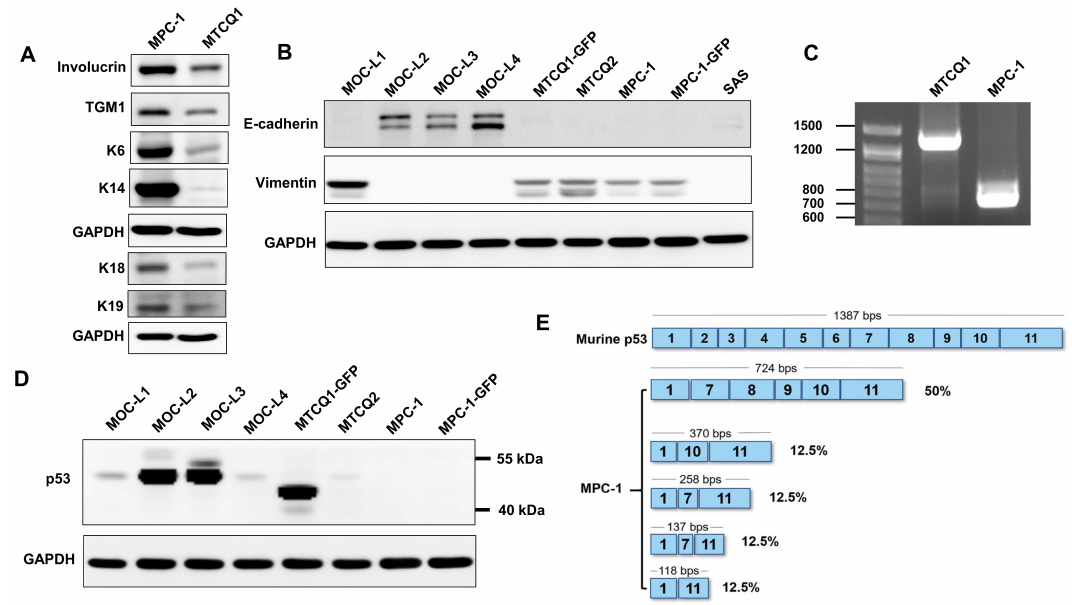
Figure 2. Confirmation of MPC-1 as a p53 null OSCC cell line. ( A , B , D ) Western blot analysis. ( A ) Analysis of the keratinocyte markers. The MPC-1 cell line expresses keratinocyte markers much more strongly than the MTCQ1 cell line. ( B ) MPC-1, MOC-L1, MTCQ1, and MTCQ2 are positive for expression of vimentin, but negative for expression of E-cadherin. The other murine OSCC cells express E-cadherin. ( C ) RT-PCR analysis. This shows a ~700 bps p53 transcript in MPC-1 and a ~1200 bps p53 transcript in MTCQ1 cell. Note that the bands with a mobility below 600 bps position are not shown in this picture. ( D ) The analysis of p53 protein in OSCC cells. High p53 protein expression levels can be seen in the cell lines harboring p53 mutations. MTCQ1 has a truncated p53 protein. No p53 expression can be seen in the MPC-1 cells. ( E ) Sequencing of bacteria colonies carrying RT-PCR products. This reveals the presence of the truncated transcript originally engineered into the knockout mouse (deletion of exon 2–6) in 50% of the white colonies, while four shorter truncated variants make up the remaining 50%